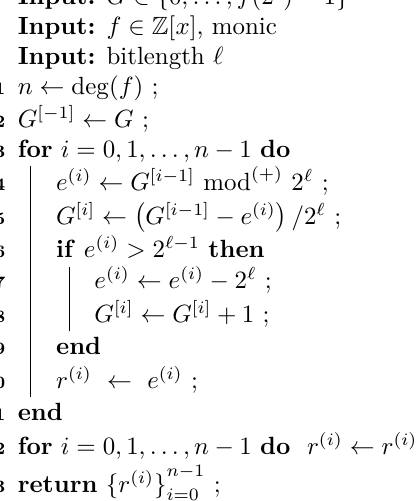
Algorithm 8: Sneeze ( G, f, ‘